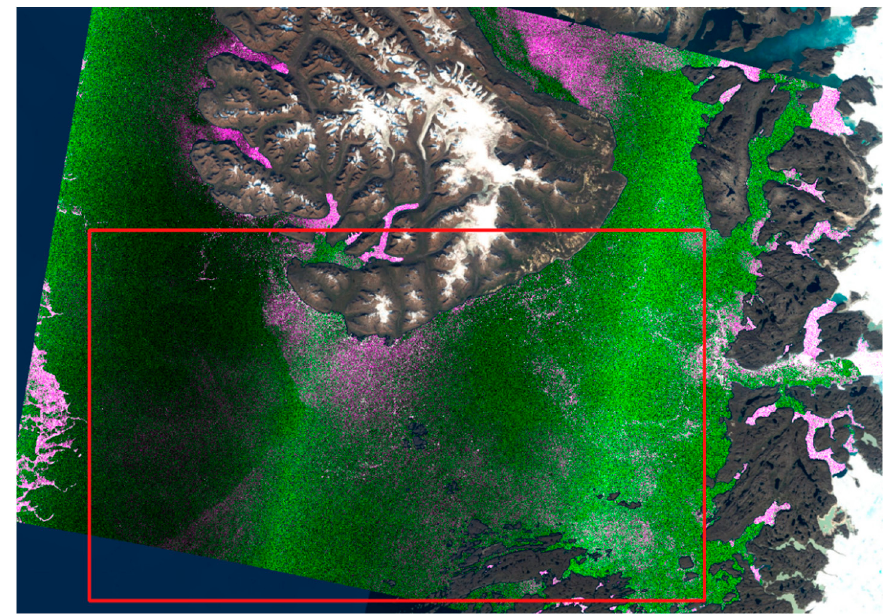
Figure 5. April 18, 2020, Disko Bay Sentinel-1 RGB composite cropped with a coastline and overlaid on a Sentinel-2 image mosaic.